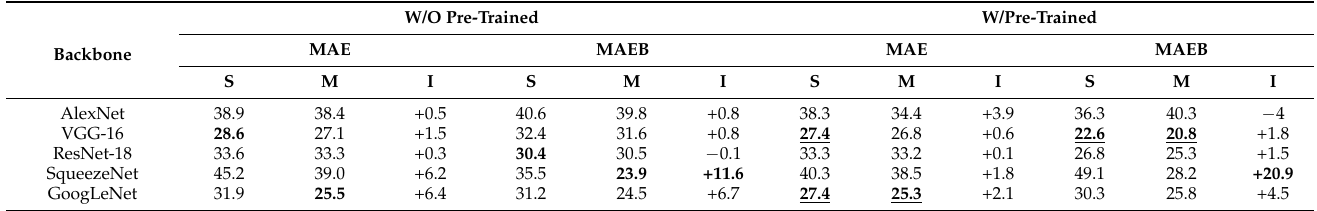
Table 3. Performance comparison on the original unseen test set. In the table, the baseline model is denoted as S and the proposed multitask learning model is denoted as M. The column “I” indicates the improvement achieved by applying multi-task learning.